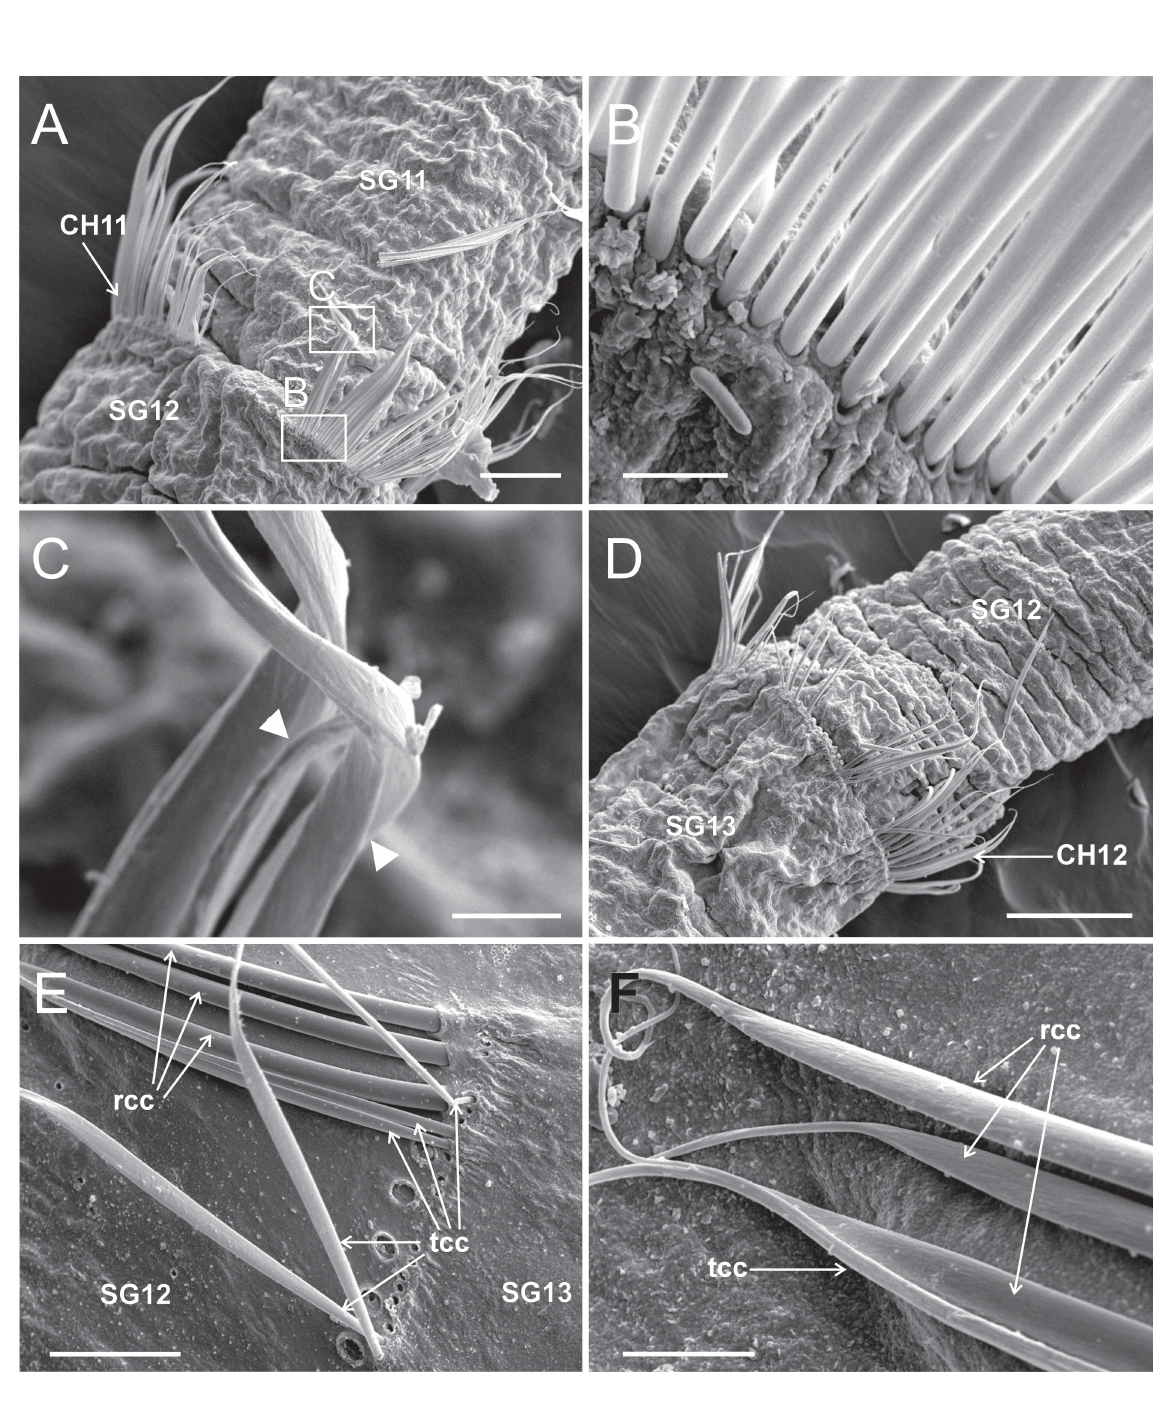
Fig. 5. Heterospio indica sp. nov., paratype (MNCN 16.01/17000), SEM micrographs. A . SG11–SG12, dorsal view, framed areas showing chaetal details in (B) and (C) (scale bar = 50 m m). B . Basal part of CH11 chaetae (scale bar = 5 m m). C . Distal part of CH11 capillary chaetae, arrowheads showing start of distal opening (scale bar = 5 m m). D . SG12–SG13, dorsal view (scale bar = 100 m m). E . Basal part of CH12 chaetae (scale bar = 25 m m). F . Distal part of CH12 chaetae (scale bar = 10 m m). Abbreviations: CH = chaetiger; rcc = robust capillary chaetae; SG = segment; tcc = thin capillary